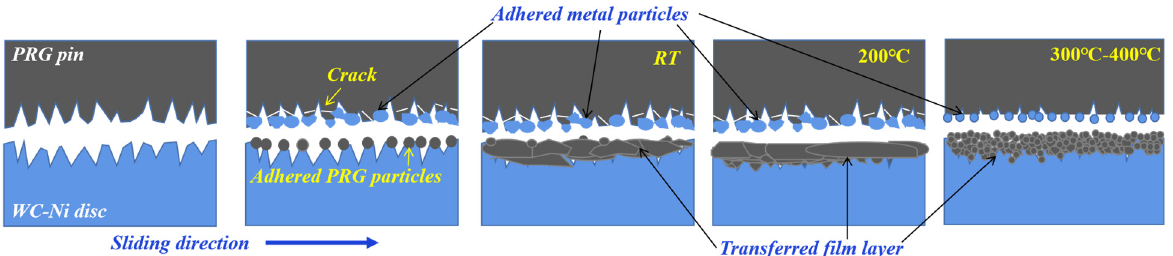
Figure 8. Schematic diagram of transferred film formation of PRG at high temperature.